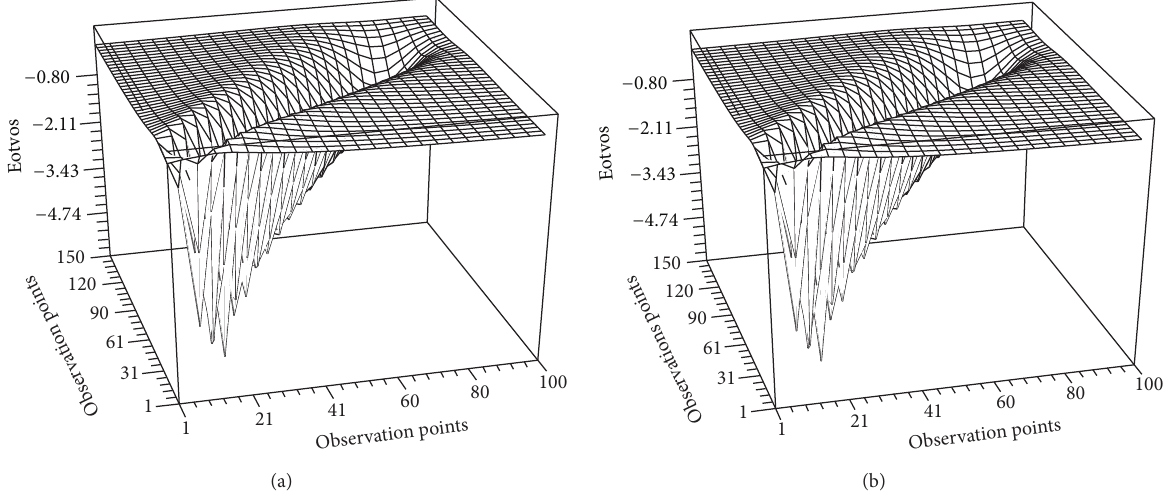
Figure 18: Component 𝑧𝑧 of the tensor 𝐺(𝐺 𝑧𝑧 ) , (a) calculated in double precision, (b) calculated in single precision. No significant differences are noticed between the